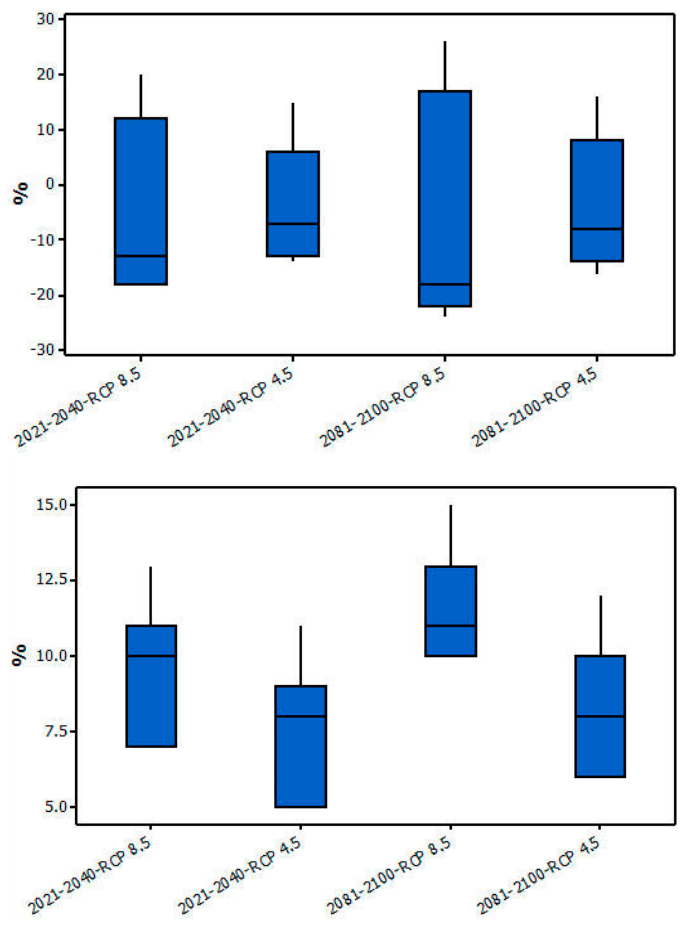
Figure 7. Box plot of projected changes of runoffs with seven GCMs in dry ( top ) and wet ( bottom ) seasons. Seasonal Variability of Flow